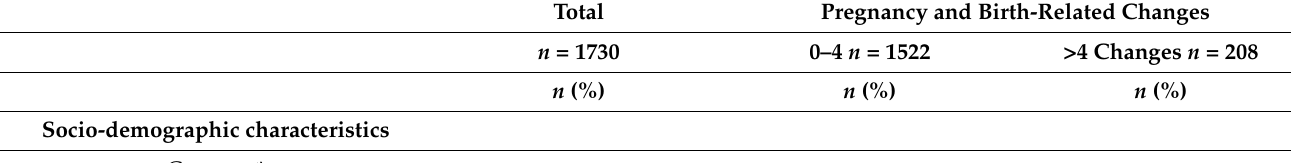
Table 1. Characteristics of the study participants according to pregnancy and birth-related change categories, n = 1730 .